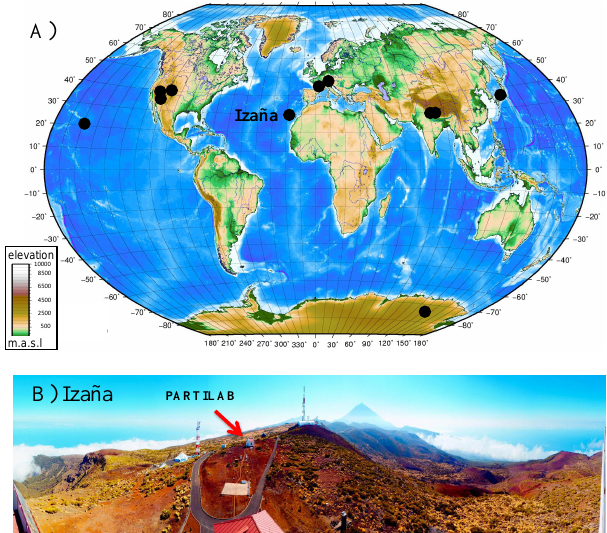
Fig. 1. (A) Global map highlighting the location of Izaña and of other high-altitude observatories where studies on NPF have been performed. From west to east: Mauna Loa, Hawaii (3400ma.s.l.; Weber et al., 1995, 1999); Storm Peak Laboratory, Colorado (3210ma.s.l.; Hallar et al., 2011); Mount Lemmon, Arizona (2700ma.s.l.; Shaw et al., 2007); Rocky Mountains, Colorado (2900ma.s.l.; Boy et al., 2008); Izaña, Tenerife (2373ma.s.l.; this study); Puy de Dôme, France (1465ma.s.l.; Venzac et al., 2007; Boulon et al., 2011); Jungfraujoch, Swiss Alps (3580ma.s.l.; Boulon et al., 2010); Mukteshwar, Indian Himalayas (2180ma.s.l.; Neitola et al., 2011); Pyramid, Nepal (5079ma.s.l.; Venzac et al., 2008); Norikura, Japan (2770ma.s.l.; Nishita et al., 2008); and Dome C, Antarctica (3200ma.s.l.; Järvinen et al., 2013). (B) View of the PARTILAB (particles laboratory) from the Izaña observatory main